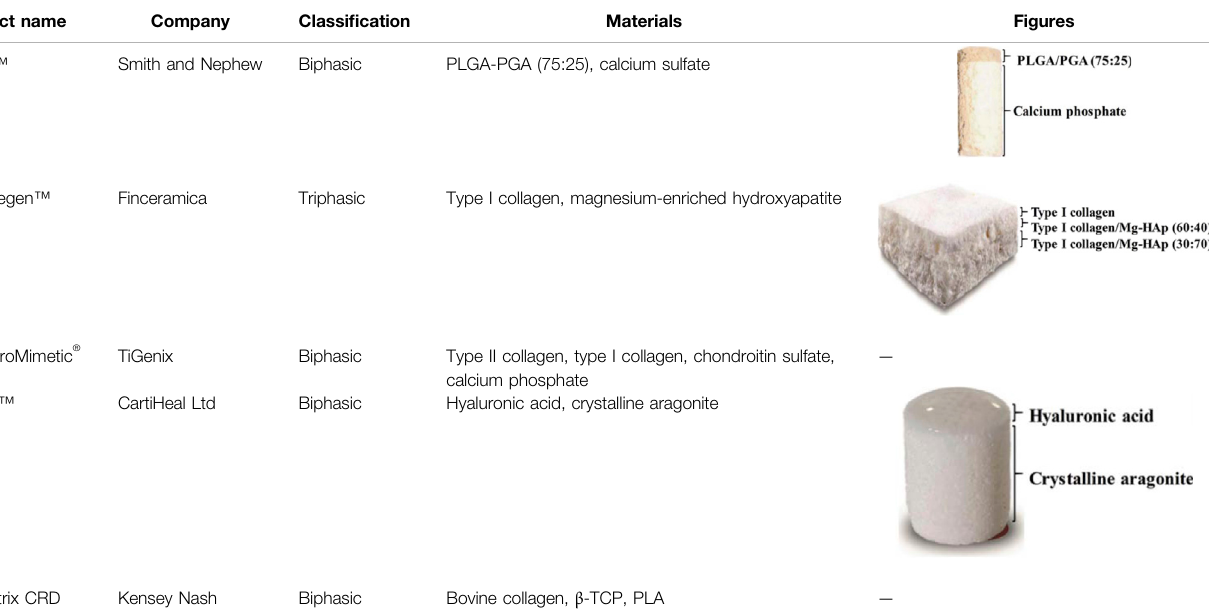
TABLE 3 | Hierarchical commercial products for OC tissue regeneration approved in the European